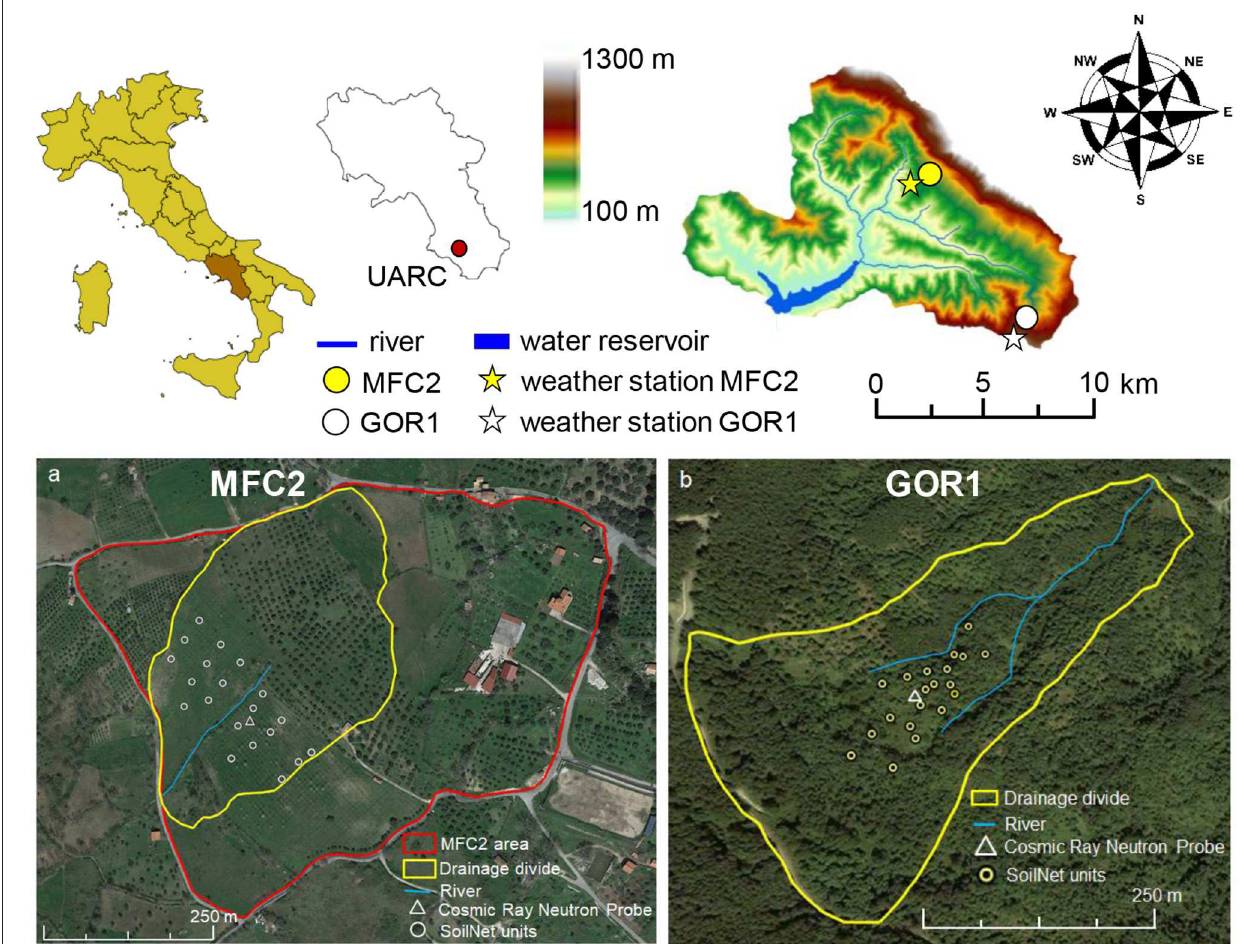
FIGURE 1 | Geographical location and 5-m Digital Elevation Model (DEM) of the Upper Alento River Catchment (UARC) in Campania (southern Italy), with the two experimental sites (MFC2 and GOR1) and corresponding weather stations displayed in the upper plots. The artificial water reservoir is delimited by the Piano della Rocca earthen dam. The layouts of the 20 end-devices of the SoilNet wireless sensor network and Cosmic Ray Neutron Probe are displayed on the satellite image (on the bottom plots) at MFC2 (plot a ) GOR1 (plot b